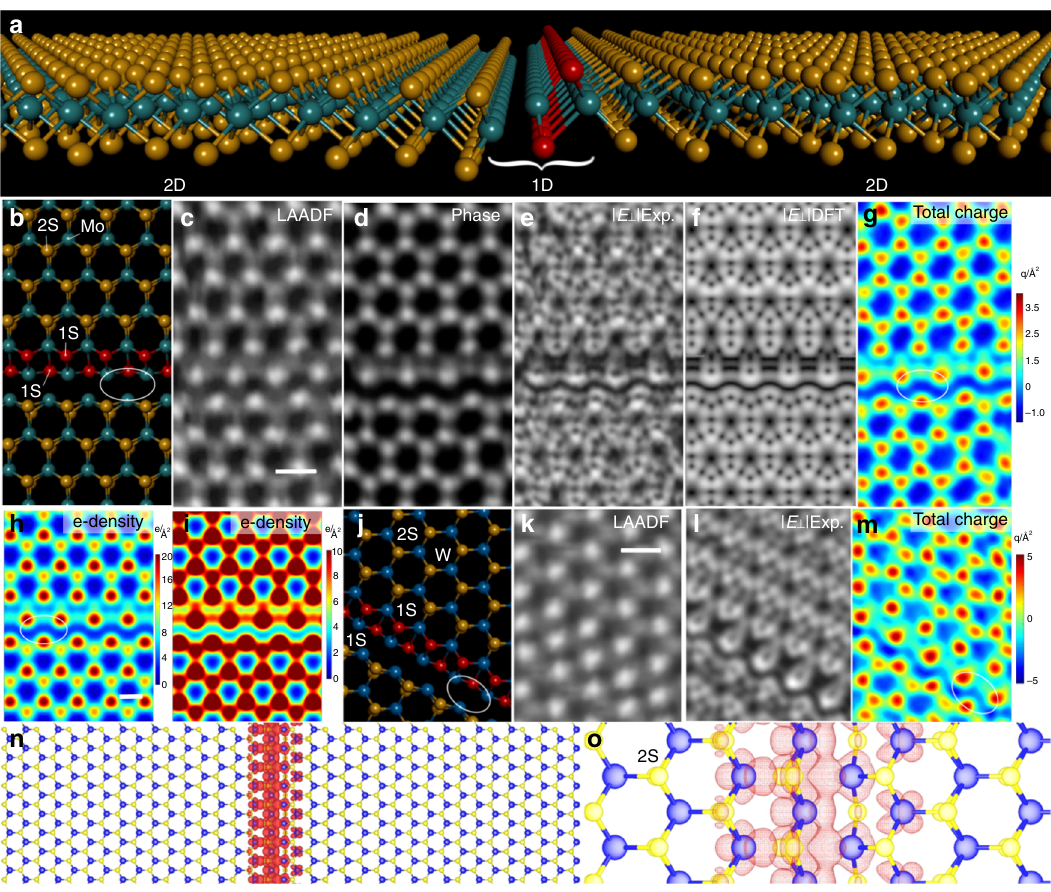
Fig. 2 4D STEM around 1D line defects in MoS 2 and WS 2 . a Perspective view of an atomic model of the 1D vacancy line consisting of 2S missing atomic rows. b Atomic model of an MoS 2 line defect (2S), red indicates 1S and orange 2S. c LAADF image of a line defect area in MoS 2 reconstructed from 4D STEM data. Scale bar indicates 0.3 nm and is applicable for panels ( b ) − ( g ). d Phase map of a line defect area in MoS 2 from ptychography using 4D STEM data. e Experimental | E ┴ | map around a line defect in MoS 2 : I com x , normalized and scaled to match the DFT values. f DFT calculations of | E ┴ | around a line defect in MoS 2 . g Total charge map ( q /Å 2 ) around line defect in MoS 2 from 4D STEM data, scaled and normalized to match DFT range. h Electron charge density map (electrons/Å 2 ) around a line defect in MoS 2 calculated from DFT. Scale bar indicates 0.2 nm and is applicable for panel ( i ). i Map as in ( h ), scaled to emphasize the electron density in the Mo − Mo channel region. j Atomic model of line defect in WS 2 (2S form). Red indicates 1S and orange 2S. k LAADF image of a line defect in WS 2 reconstructed from 4D data. Scale bar indicates 0.3 nm and is applicable for panels ( j ) − ( m ). l | E ┴ | map around line defect in WS 2 from 4D STEM data: I com x , normalized and scaled to the range to match the DFT values. m Total charge map ( q /Å 2 ) around a line defect in WS 2 , scaled and normalized to match DFT range. White ovals indicate metallic bonding region in 1D channel. n DFT calculated plot of the in-gap states (red) for WS 2 2SV line defect. o Magni fi ed view of the DFT calculated plot of in-gap states (red mesh) from ( n